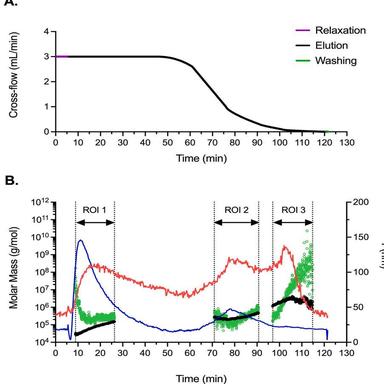
Oxidized alginate with 5% target degree of oxidation (DO5): A. characteristic elution pattern (120 min); B. AF4 fractogram: detector signal from MALS at 90◦ light scattering (red line), differential refractive index dRI (blue line), molar mass distribution (black circle ○, g/mol) and root-mean-square radius distribution (green circle ○, nm) versus the elution time (min). Three ROIs with distinctive peaks are detected and correspond to the soluble alginate (67 kDa, ROI 1), unreacted alginate (250 kDa, ROI 2